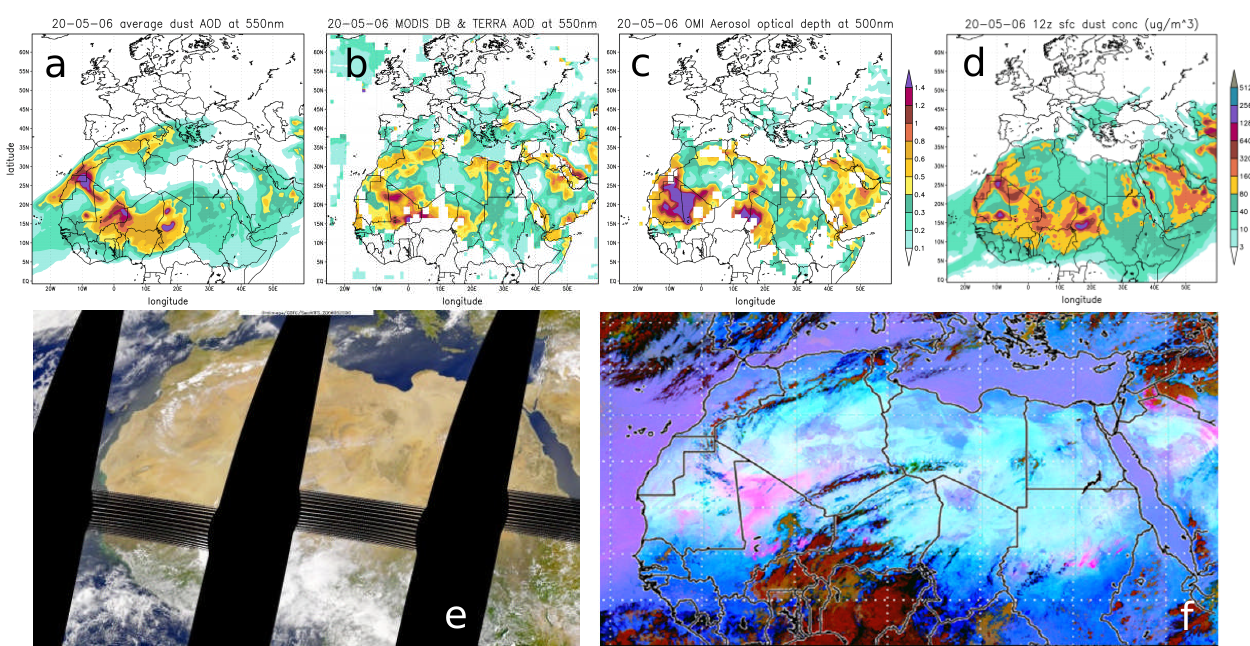
Fig. 6. The same as in Fig. 2, but for 20 May